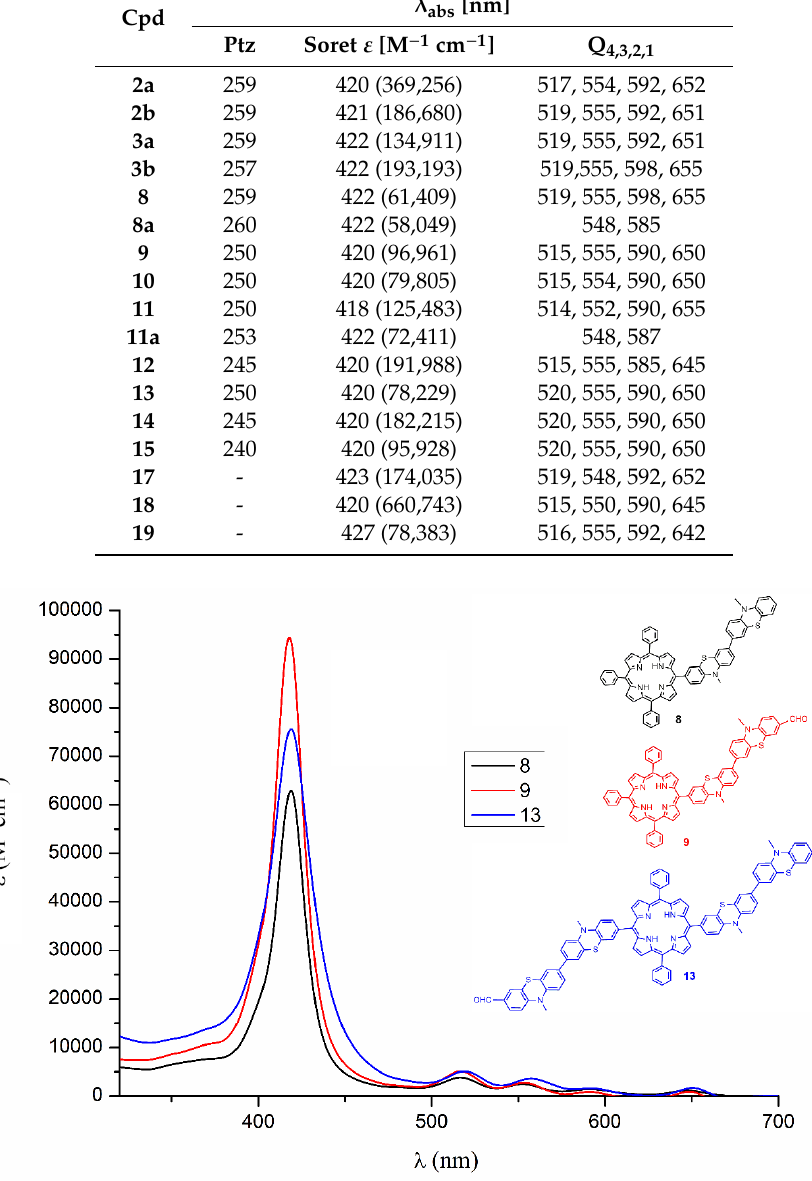
Table 2. UV–Vis linear optical properties of metal complexes of bromoMPP (4, 5) and chloroMPP (6,7) in DCM solution.